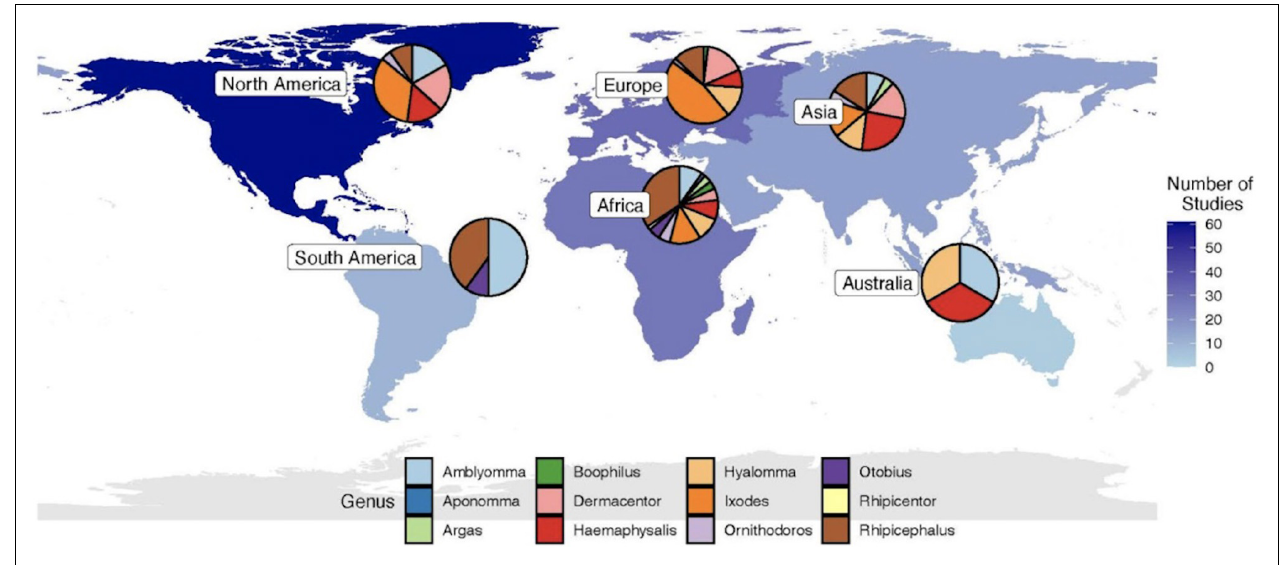
FIGURE 3 | Global distribution of included tick habitat suitability studies by tick